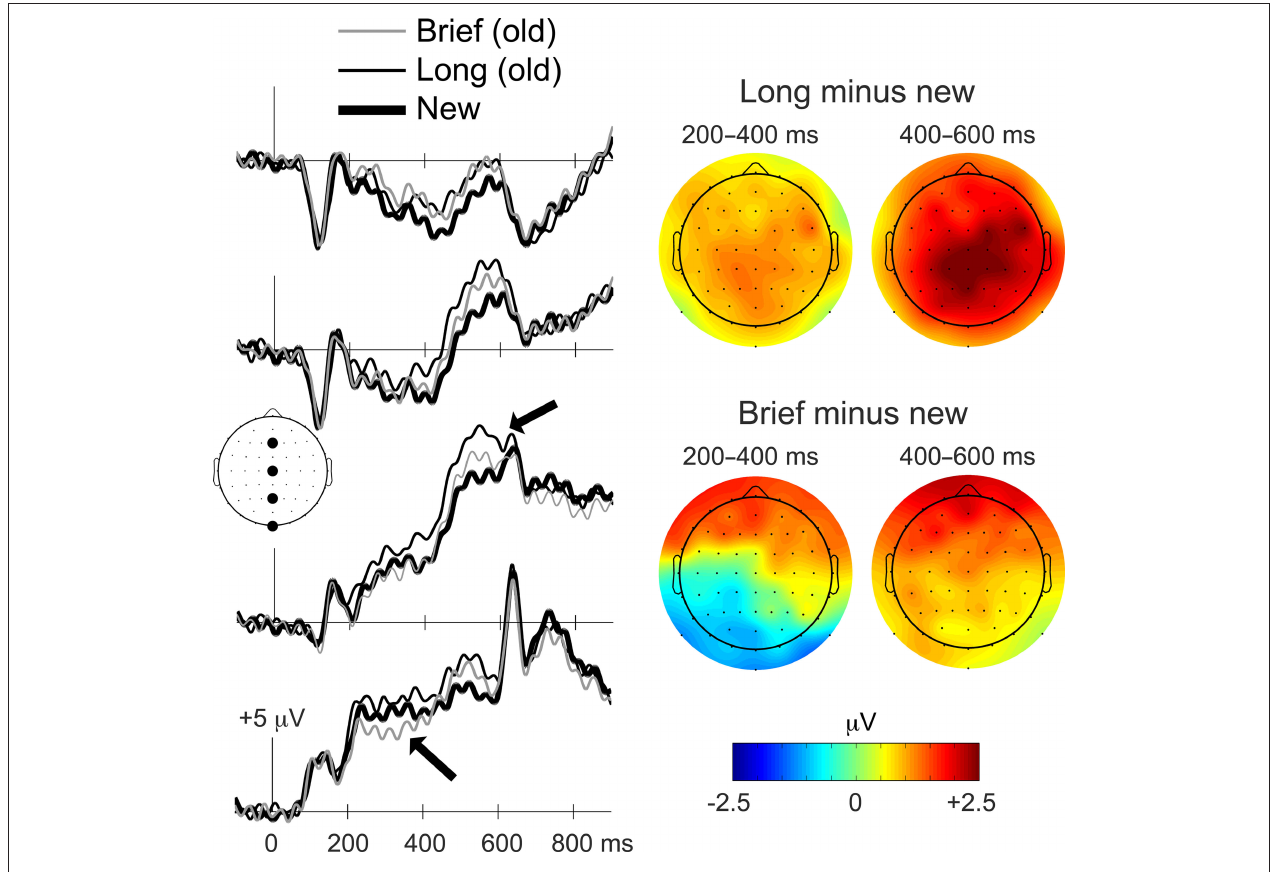
greater negative differences. Arrows are used to highlight the ERP old/new effect attributed to recognition (upper arrow) and the effect attributed to priming (lower arrow). The distinction between ERPs attributed to priming and recognition is also apparent in the topographic maps. The upper right topographic map is characteristic of the ERP effects attributed to recognition whereas the lower left topographic map is characteristic of the ERP effects attributed to priming. A similar distinction between Brief and Long old/new effects was evident when ERPs were computed using an average scalp reference instead of the average mastoid reference used here ( Figure A1 of